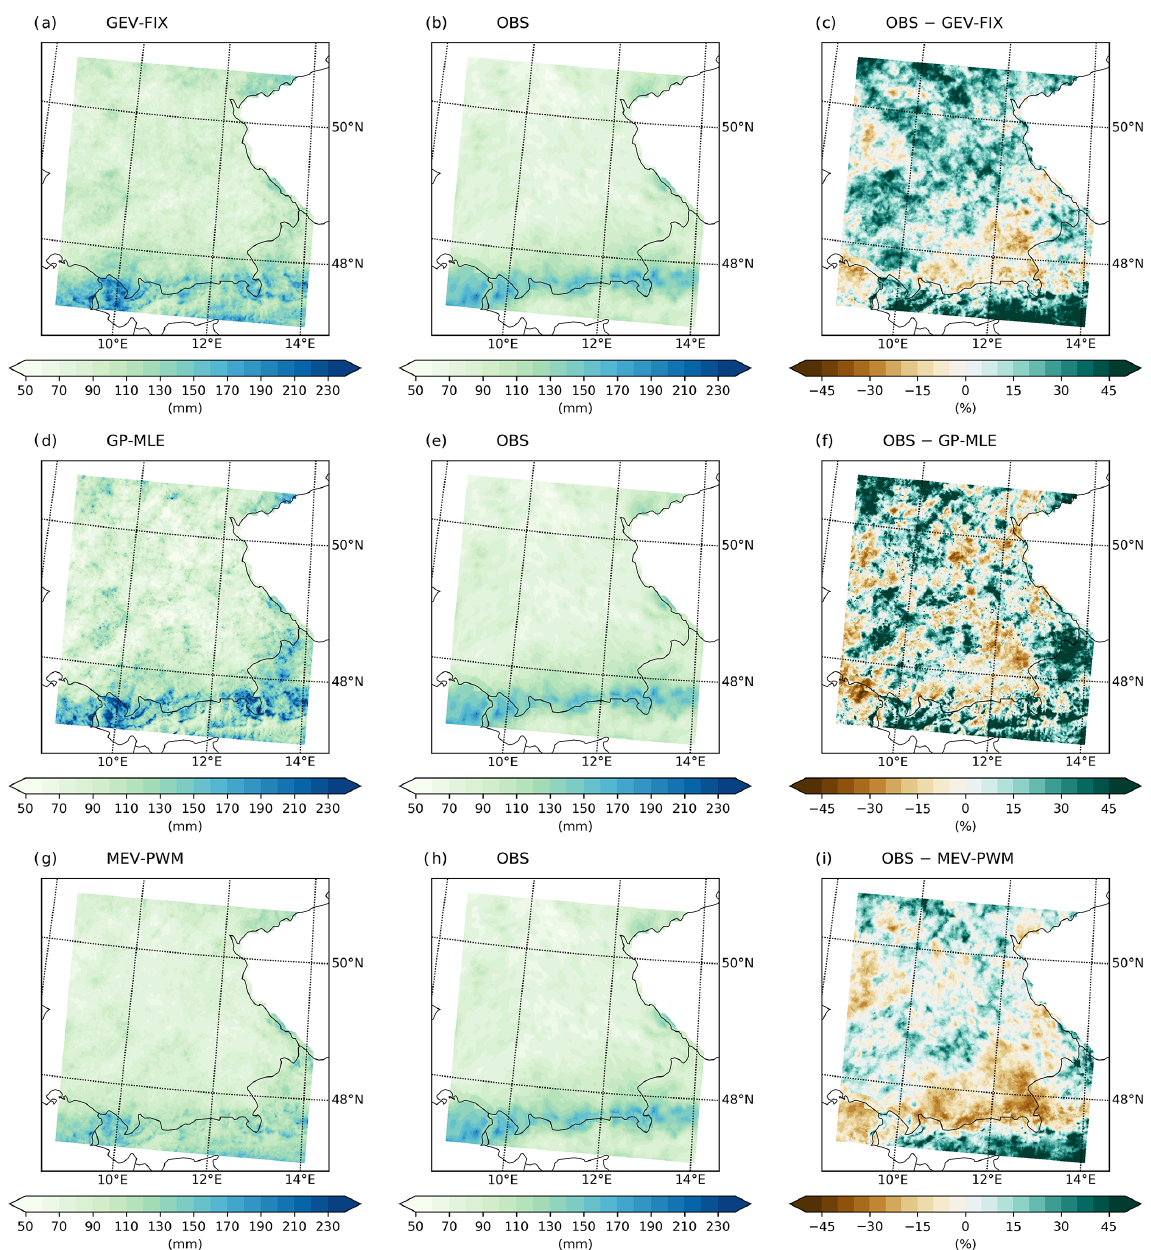
Figure 9. The 100-year rainfall return levels based on WRF ERA5 featuring GEV-FIX (a) , GP-MLE (d) , and MEV-PWM (g) . The middle column (b, e, h) shows the observational product interpolated to the WRF-ERA5 grid. The right column (c, f, i) provides the percentage difference calculated as the climate model return level minus the observational return